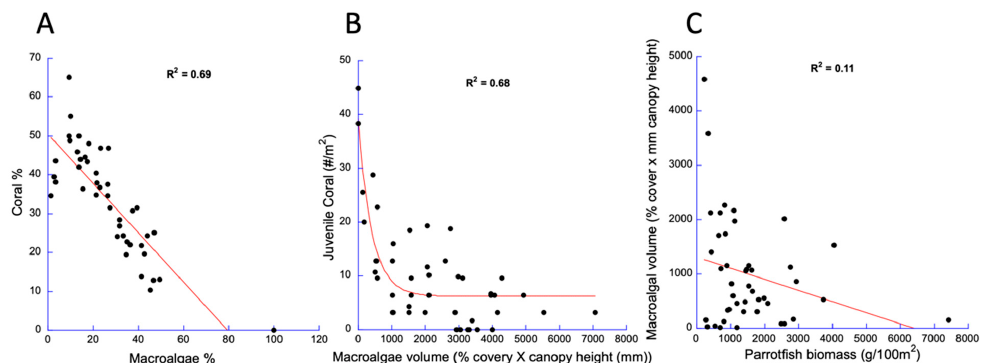
Figure 3. Support for strong drivers that limit the abundances of important components of the DR’s coral reef ecosystems. Coral cover ( A ) and juvenile coral density ( B ) were limited by macroalgae cover (N = 180, 10 m transects, N = 895, 625 cm 2 quadrats, respectively) and macroalgae limited by parrotfish abundance N = 360, 120 m 2 belt transects ( C ). Data pooled from all surveys from all years.